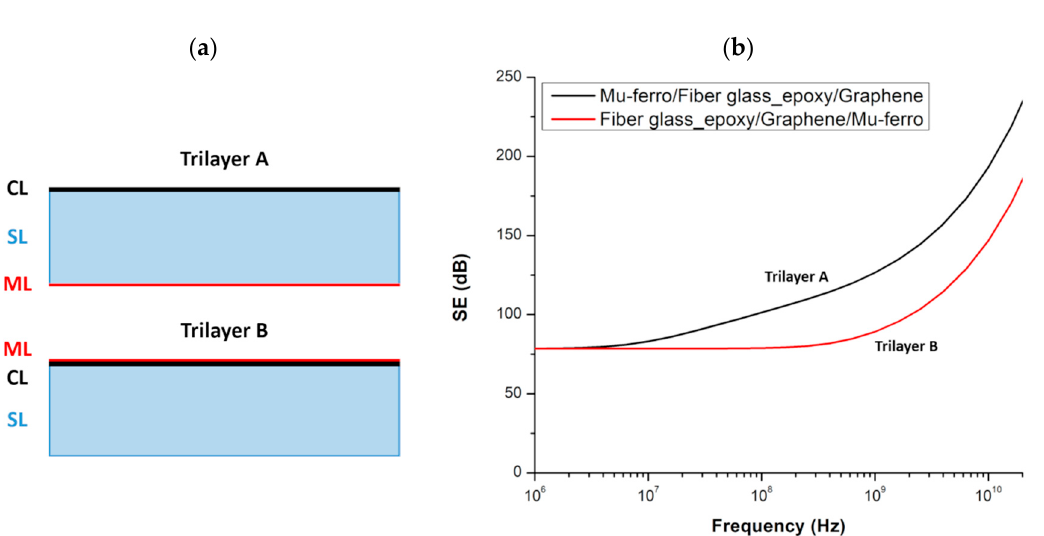
Figure 4. Schematic diagram ( a ) and shielding effectiveness ( b ) of both layer arrangements obtained in far-field with the numerical model.